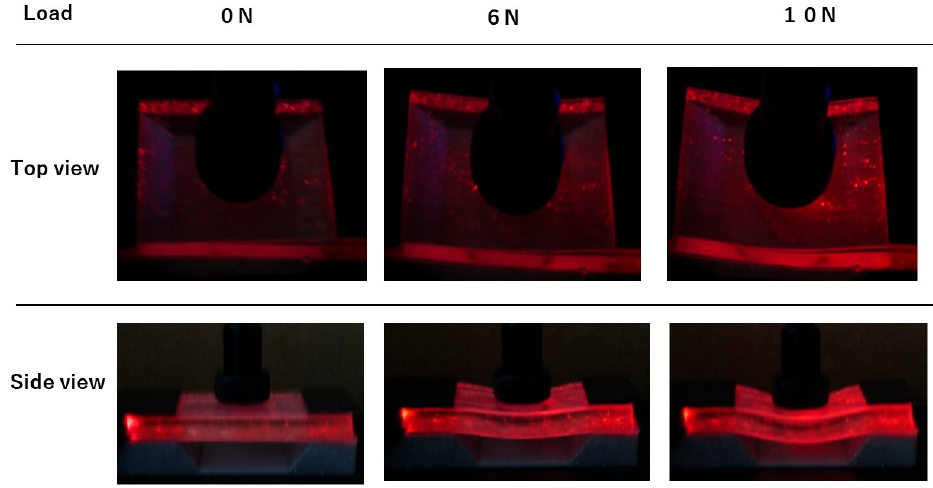
Figure 3. Photographs of light leakage due to bending.